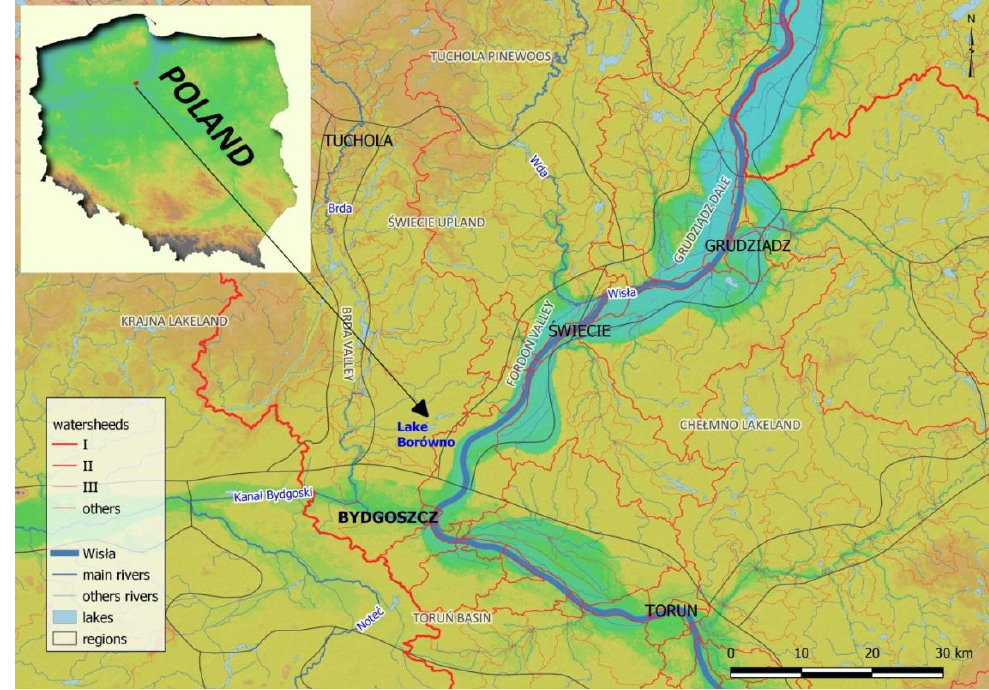
Figure 1. Location of Lake Borówno against the background of hydrographic division (prepared based on [61,62]).